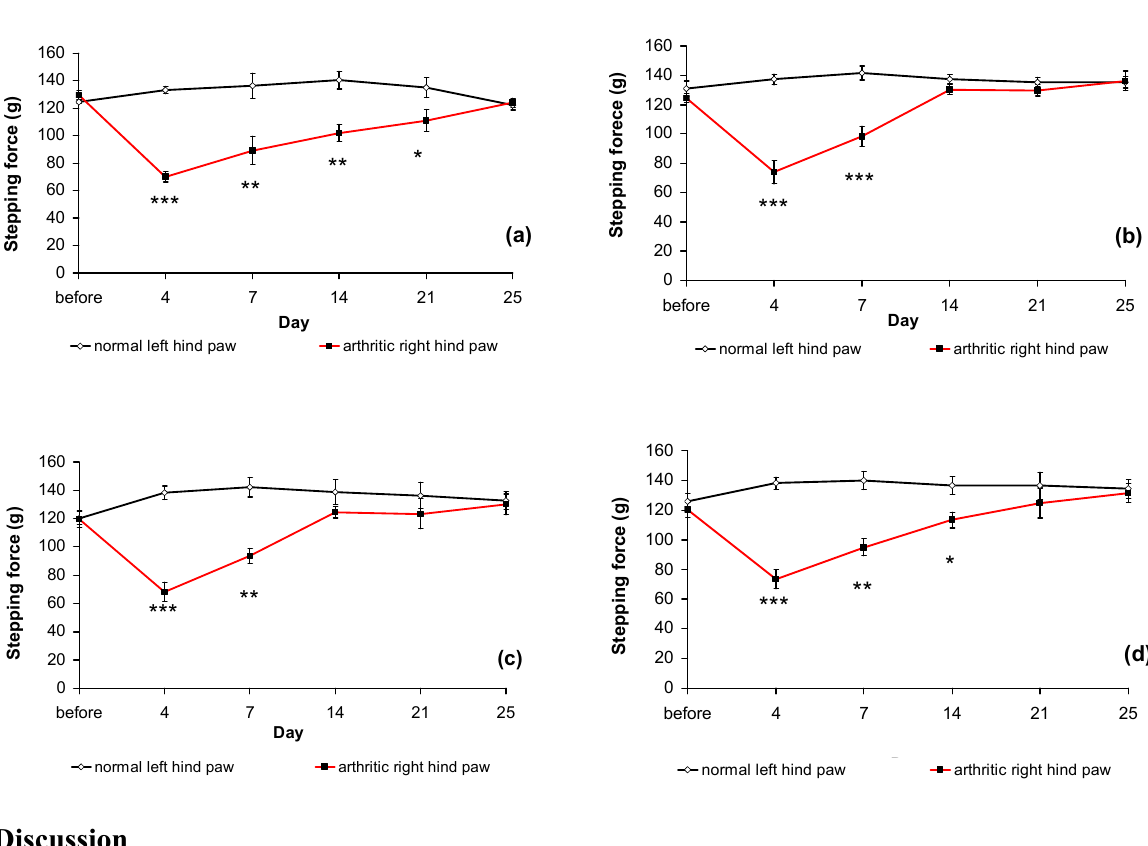
Figure 5. Stepping forces of right hind paws of FCA-induced arthritic rats. ( a ) Untreated, ( b ) orally treated with prednisolone at 10 mg/kg per day, ( c ) orally treated with prednisolone at 5 mg/kg per day, ( d ) orally treated daily with prednisolone at 2.5 mg/kg per day. (N = 6) * P < 0.05, ** P < 0.01, *** P < 0.001 compared to the stepping force of the normal left hind paw in the same